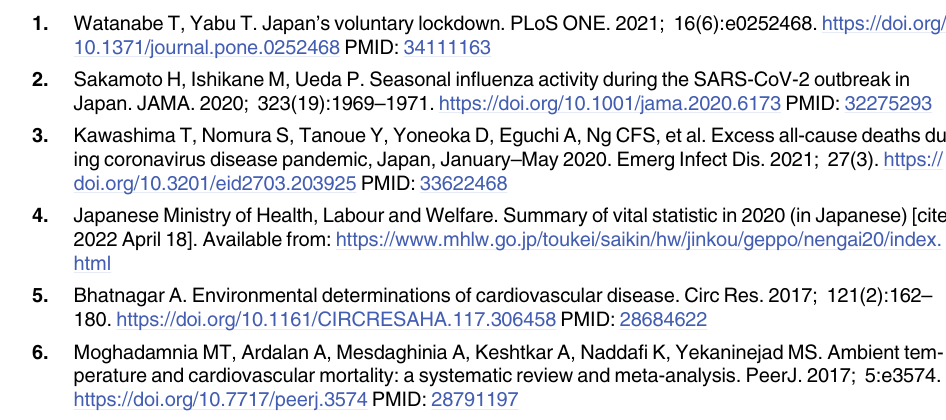
S1 Table. Predictable changes in MR study.